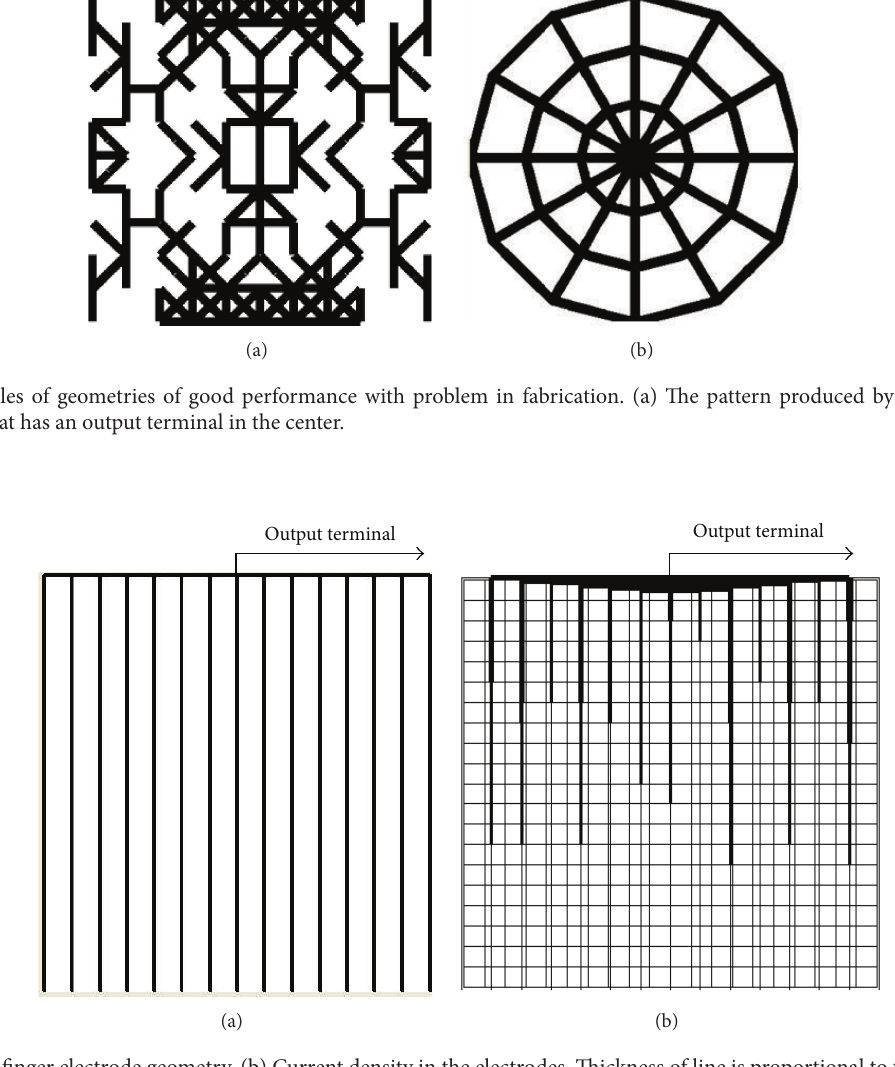
Figure 7: (a) A finger electrode geometry. (b) Current density in the electrodes. Thickness of line is proportional to the current